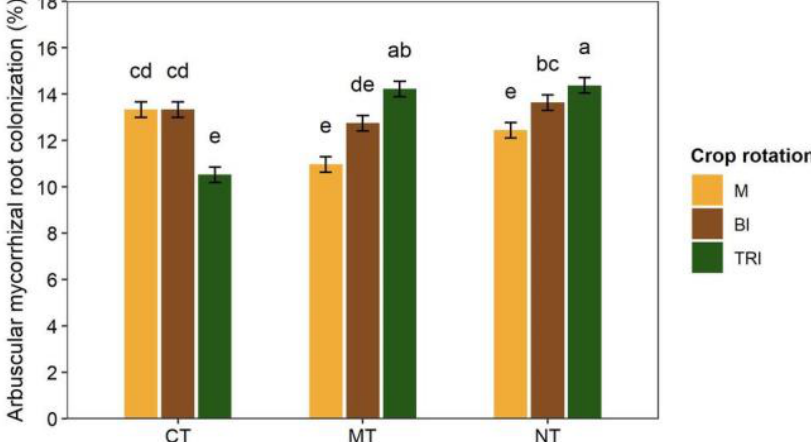
Figure 6. Effect of two-way interactions ‘Tillage × Rotation’ on arbuscular mycorrhizal root coloni- zation (%). Tillage effect (No till: NT, moderate tillage: MT, and conventional tillage: CT) and Rota- tion effect (Monocropping: M, biennial: BI, and triennial: TRI). Data are averages ± standard errors. Different lowercase letters indicate significant differences between all treatments in each item ( p < 0.05).